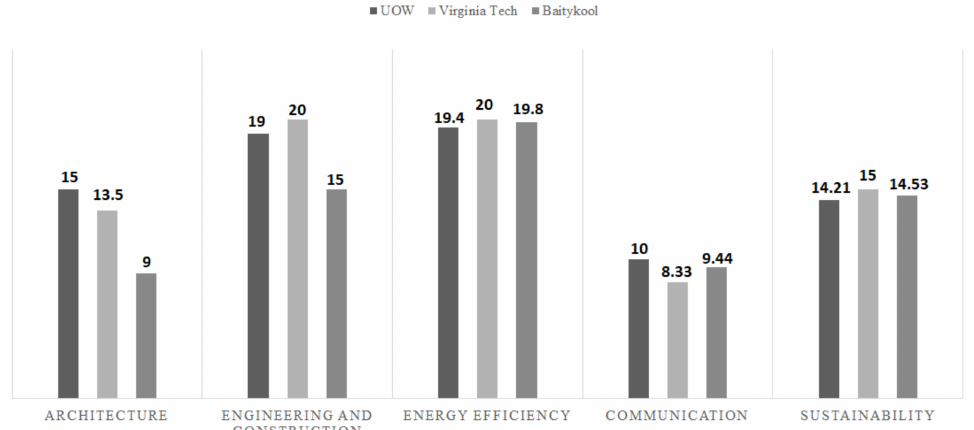
Figure 16. Innovation contest scoring for Team UOW and place getters in SD Middle East 2018.